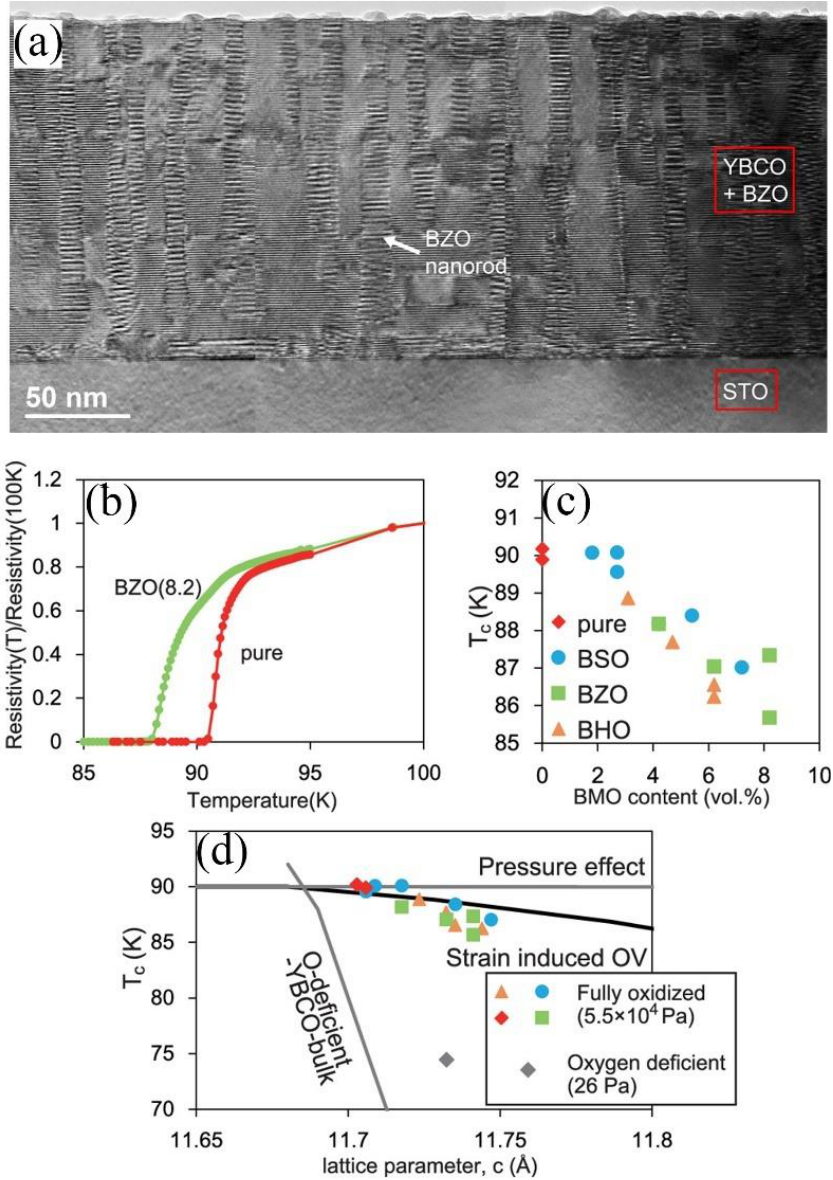
Figure 11. ( a ) BF-STEM image of the YBCO+BZO film. ( b ) T vs. normalized R in the pure YBCO and YBCO+BZO films. ( c ) T c vs. B M O content in nanocomposite films. ( d ) T c vs. c -lattice parameters. Reprinted with permission from Ref. [95]. Copyright 2017, American Chemical Society.